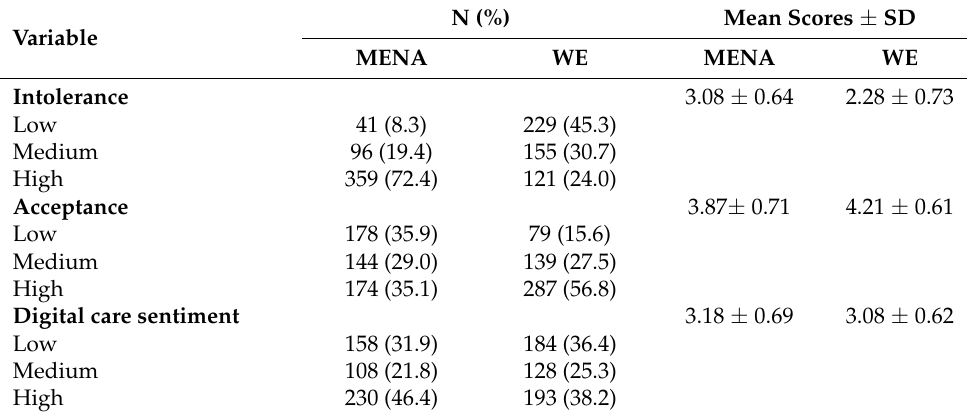
Table 4. Scores of each dimension across the Middle Eastern and Western